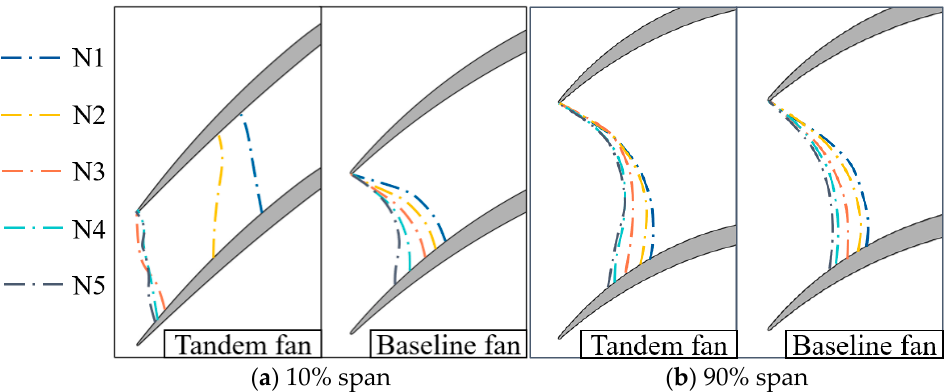
Figure 26. Aerodynamic throat position of the tandem and baseline fans at different rotating speeds.